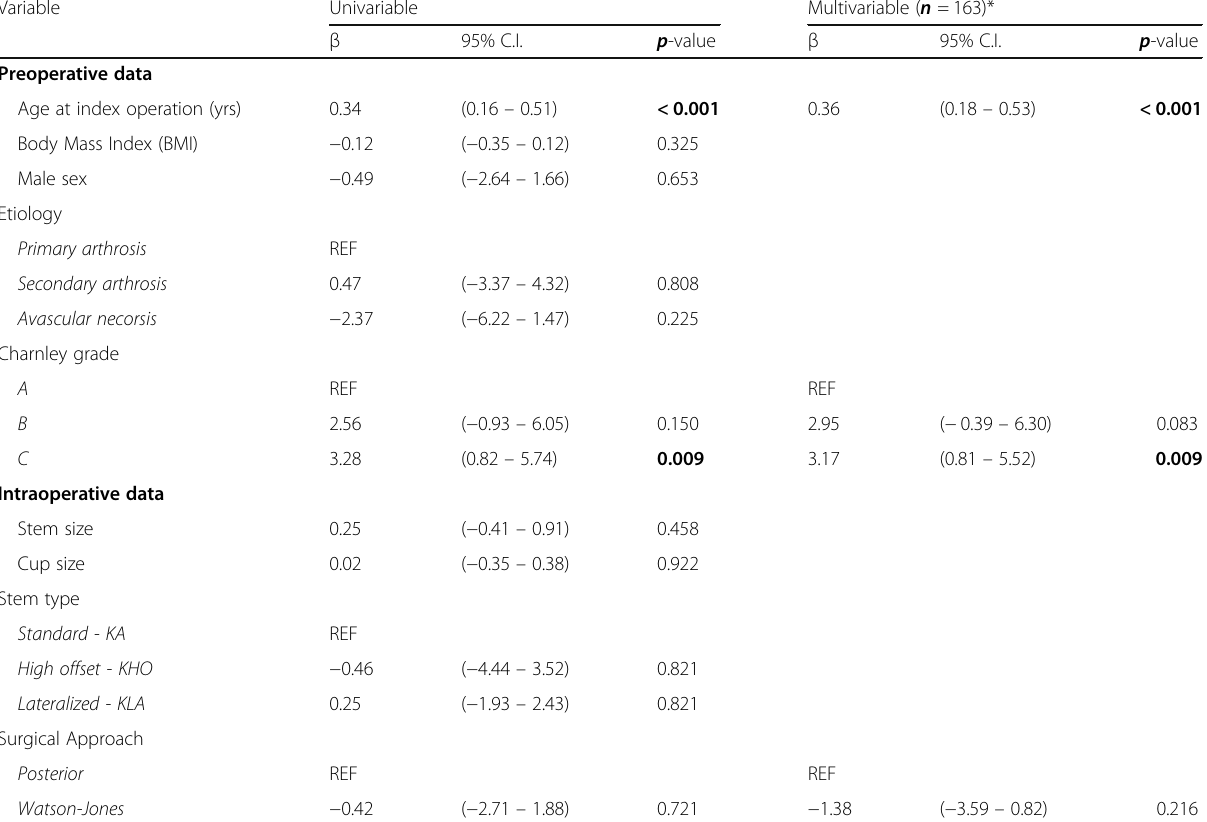
Table 4 Uni- and multi-variable regression analysis of Oxford Hip Score